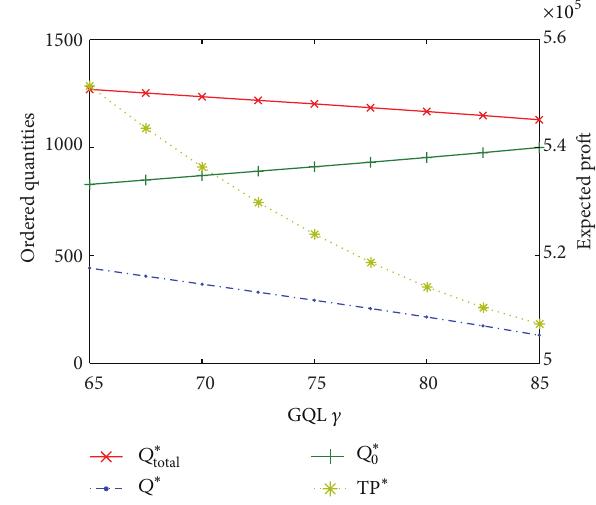
Figure 2: Effect of 𝛾 on the optimal policy.